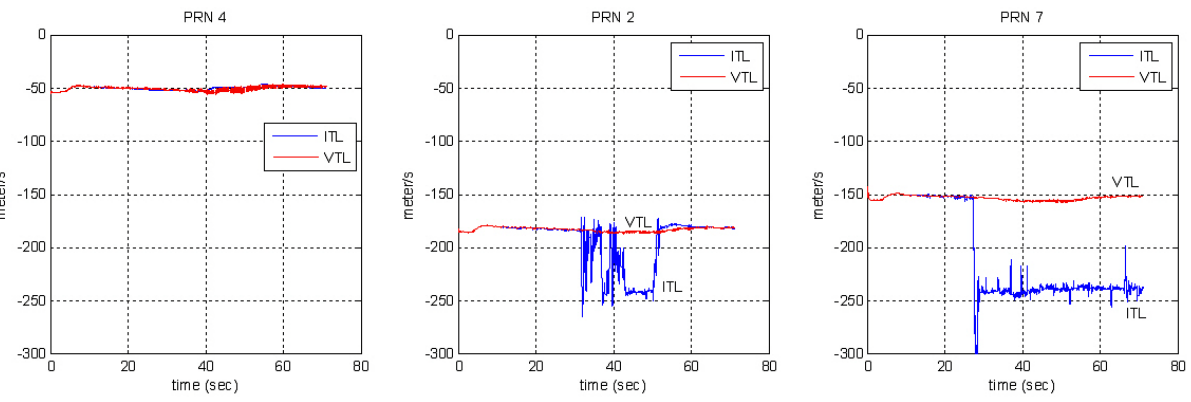
Figure 19. Range-rate